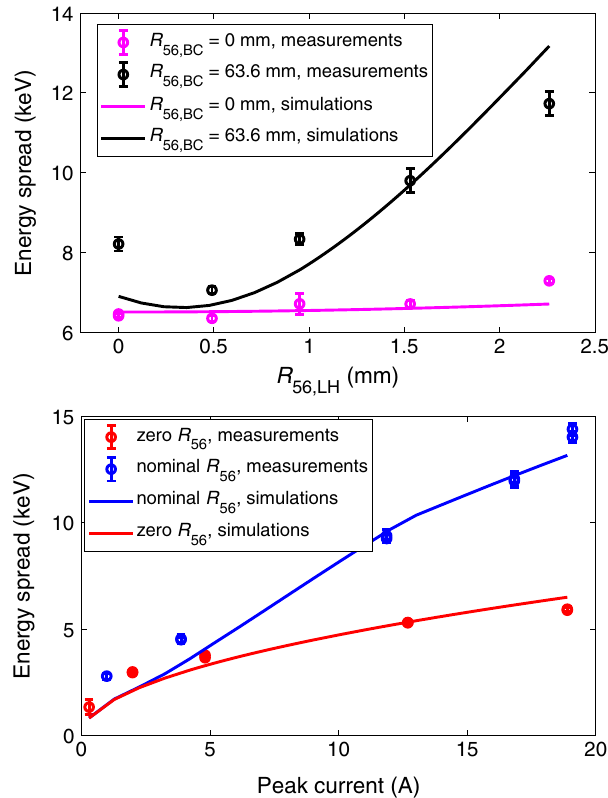
FIG. 6. Measured and simulated dependences on the lattice R 56 (top) and the peak current of the electron beam